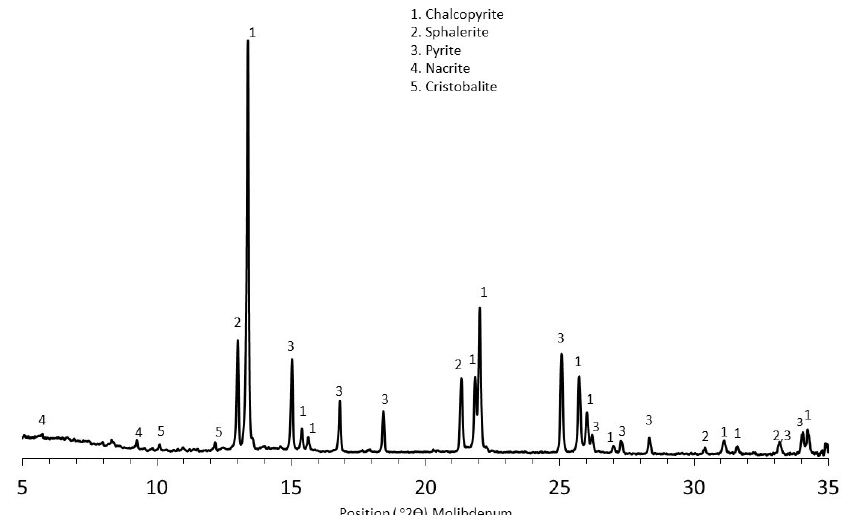
Figure 1. XRD pattern of IPB sample . Table 3. Chemical composition of IPB sample .